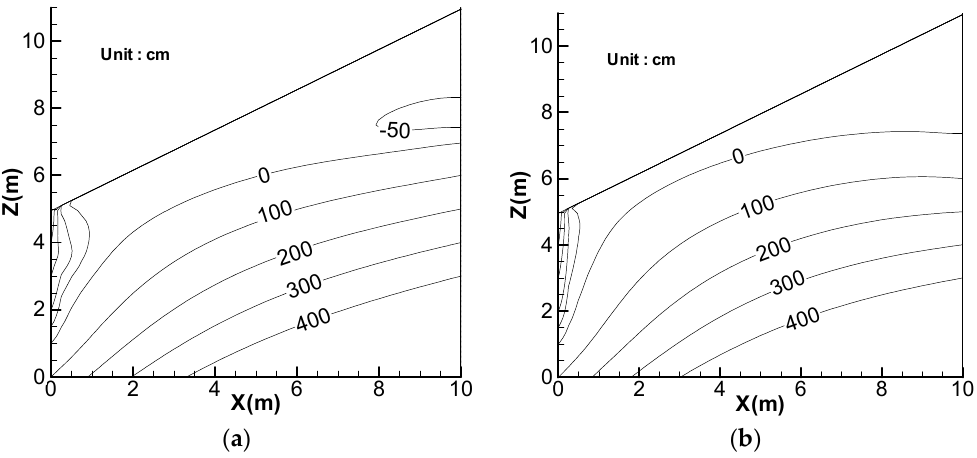
Figure 10. Pressure head contours for duration of 36 h with uniform rainfall of 400 mm at time: ( a ) 30 h; and ( b ) 36 h.